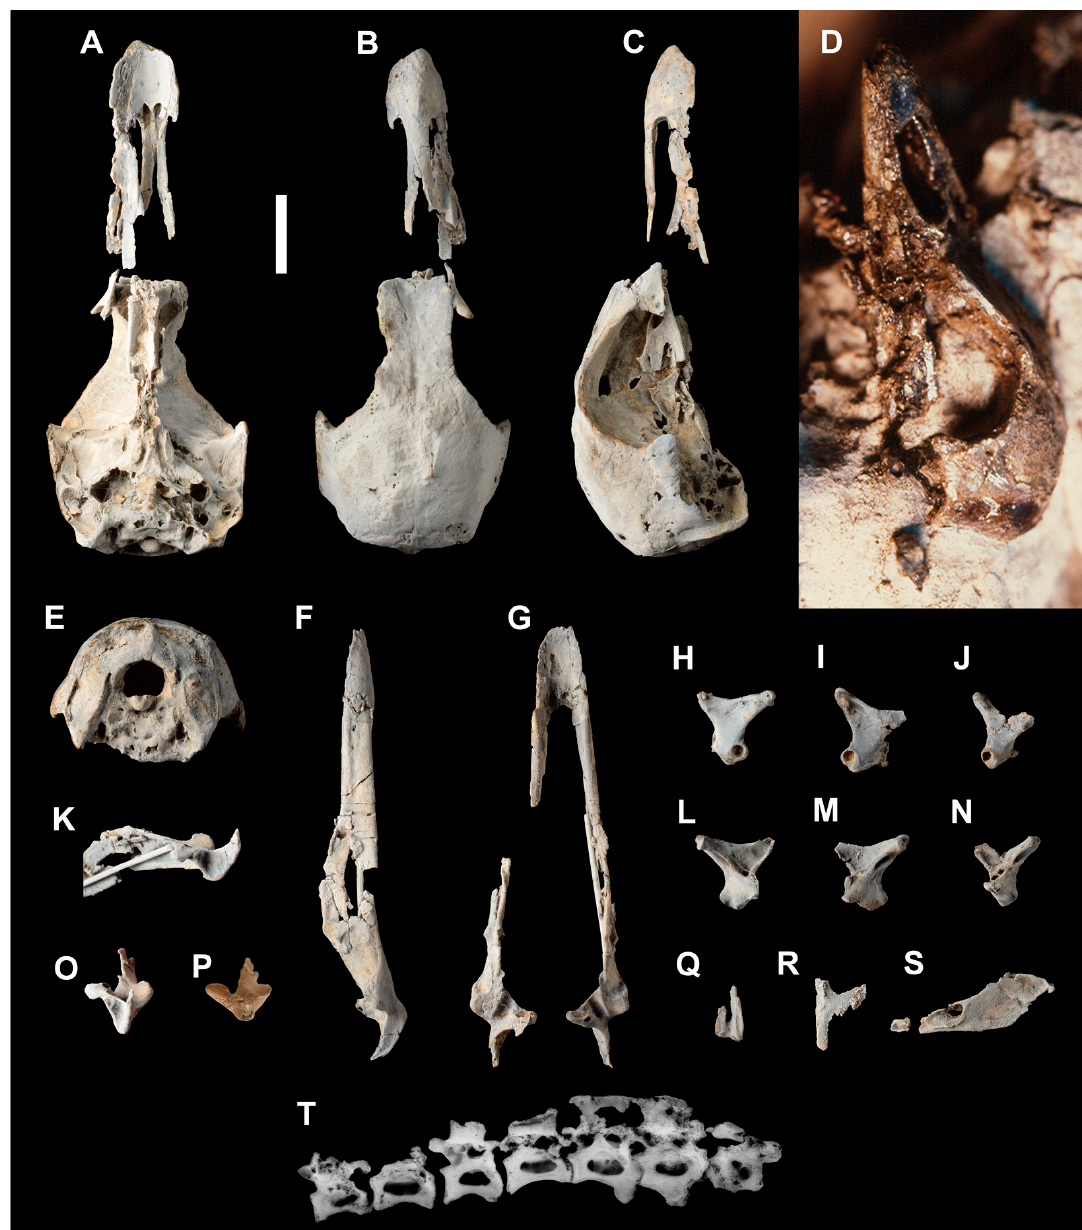
Figure 1. Holotype of Anachronornis anhimops nov. gen. et sp. (USNM 496700): skull, ventral ( A ), dorsal ( B ), right lateral ( C ), right lateral in matrix ( D ), caudal ( E ); mandible with heavy gauge wire glued to medial side of right dentary, right lateral ( F ), dorsal ( G ), oblique caudomedial aspect of right side ( K ), right caudal ( O ); quadrates, left lateral ( H ), right lateral ( I ), left medial ( L ), right medial ( M ); basihyal ( Q ), costal fragment with uncinate process ( R ), left palatine ( S ), right thoracic vertebrae ( T ). Quadrate (USNM 496701; Anseriformes fam. incertae sedis): right lateral ( J ), right medial ( N ). Holotype of Danielsavis nazensis nov. gen. et sp. (NMS.Z.2021.40.1): right caudal mandible ( P ). All but ( D ) and ( P ) are coated with ammonium hydroxide. Scale bar 1 cm. Type Locality: SE 1/4 of NE 1/4 of Sec. 19, T56N R101W, Clark Quadrangle, Park County, Wyoming.